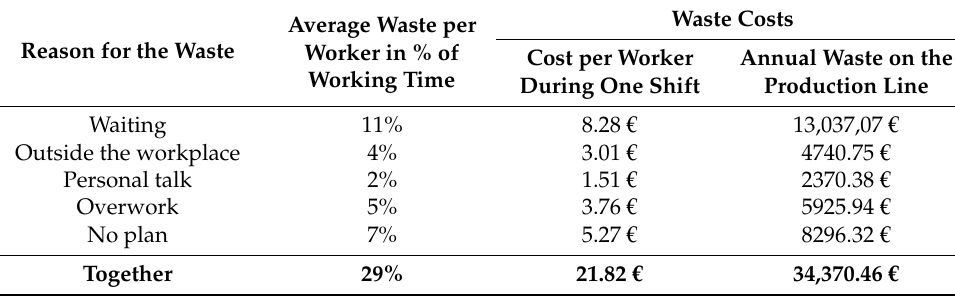
Table 2. Quantification of waste on the production